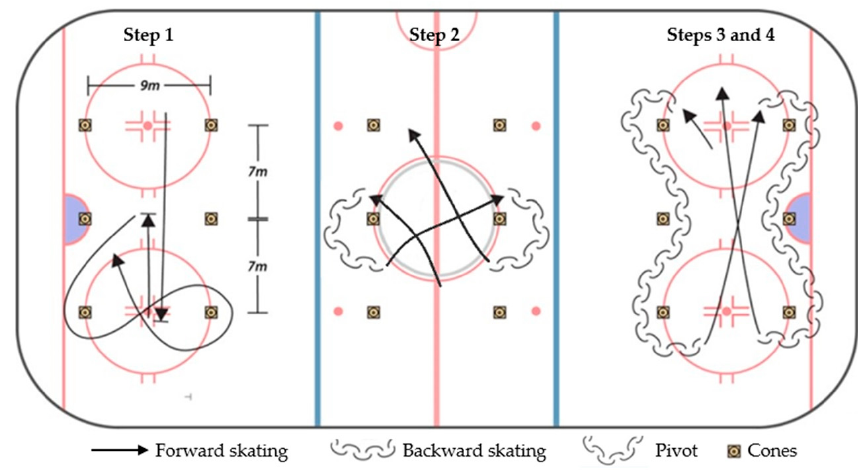
Figure 3. The skating agility test, with the four-step